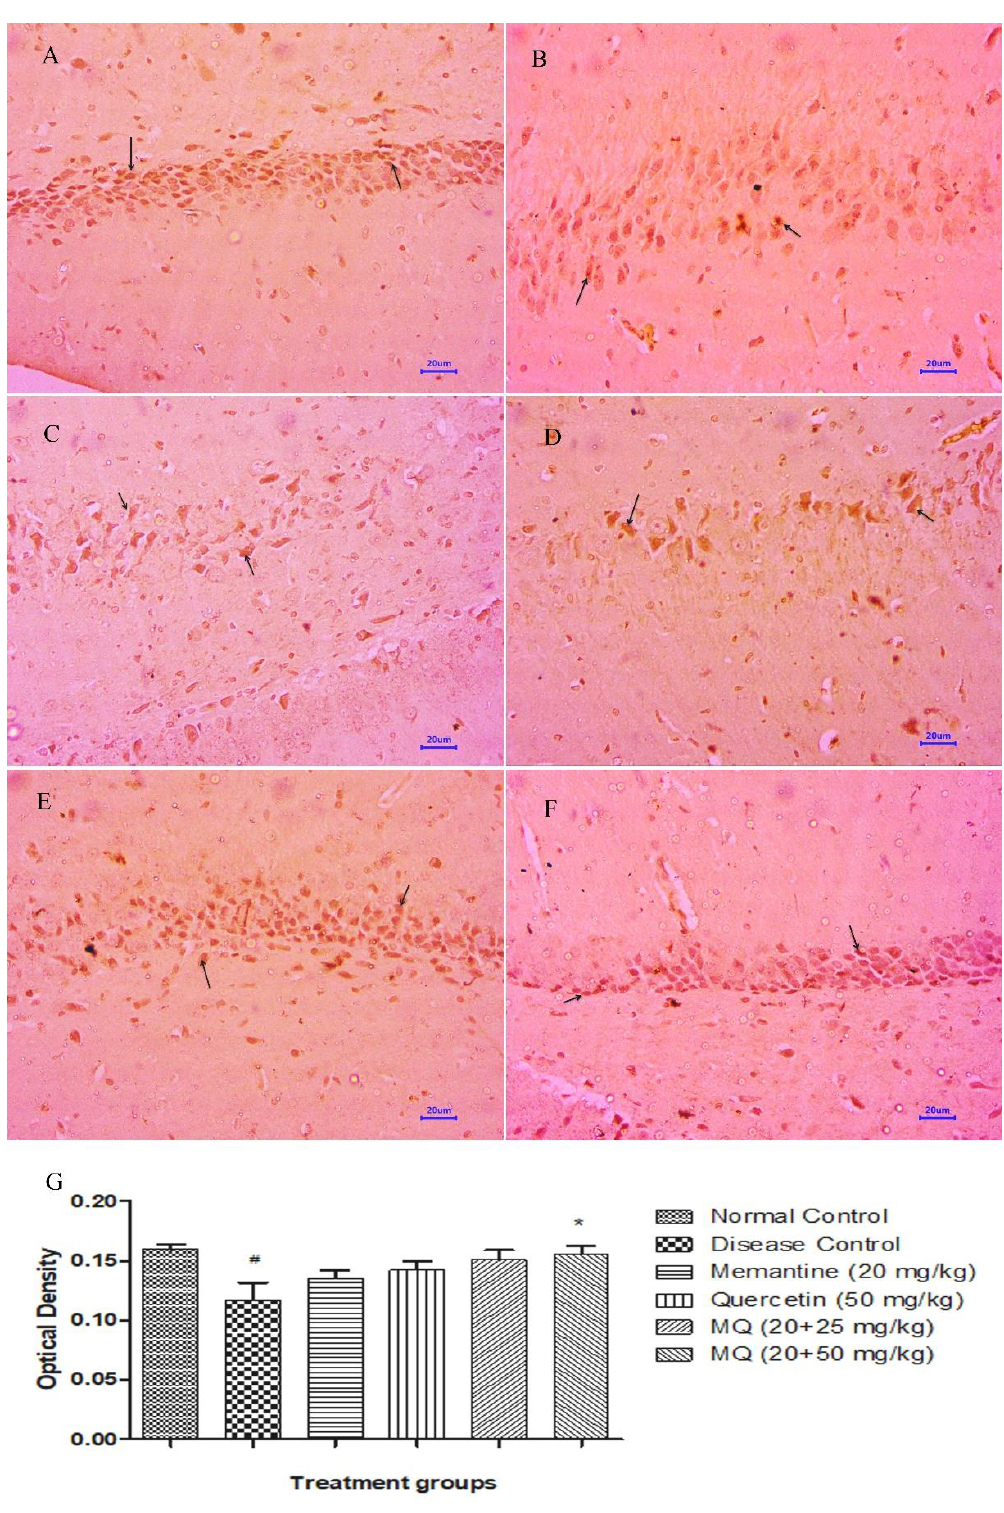
Figure 14. Effect of quercetin and quercetin administered with memantine in BDNF expression in hippocampus. ( A ): Normal control, ( B ): Disease control, ( C ): Memantine (20 mg/kg), ( D ): Quercetin (50 mg/kg), ( E ): Memantine + quercetin (20 + 25 mg/kg), ( F ): Memantine + quercetin (20 + 50 mg/kg), ( G ): Optical density data. Data expressed as mean ± SEM (n = 3), # p < 0.05 when compared with normal control group, * p < 0.05 when compared disease control group.